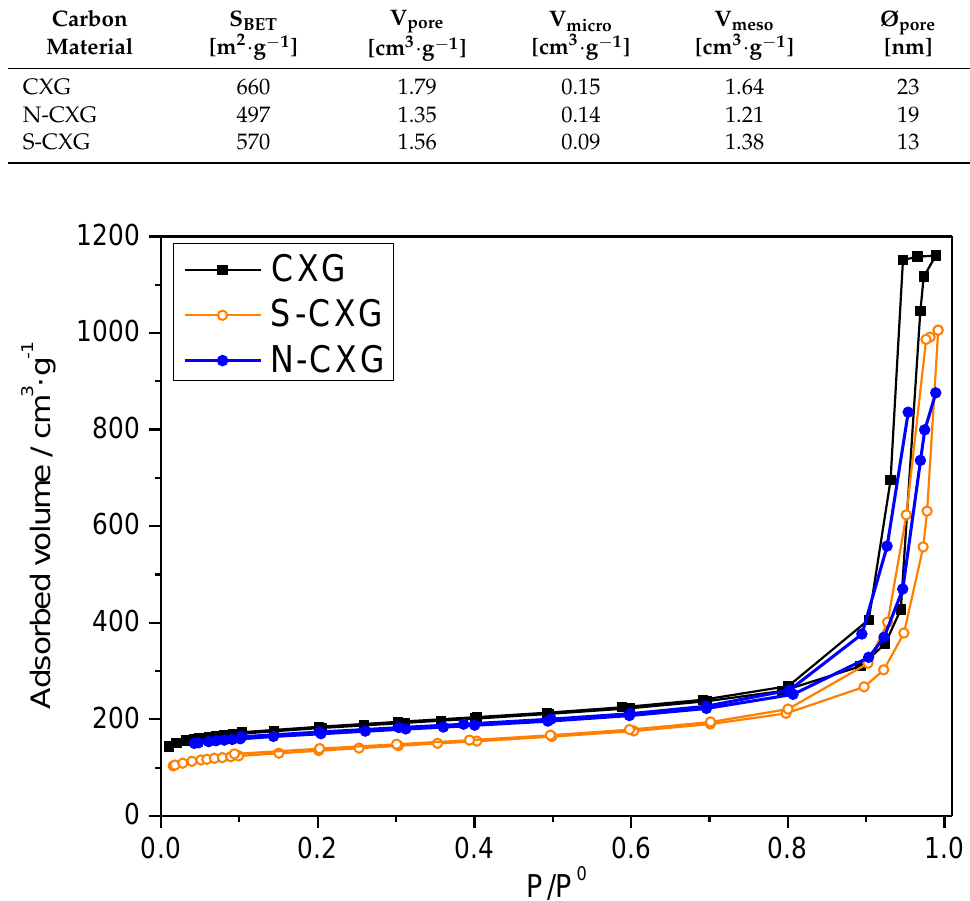
Figure 1. Adsorption–desorption isotherms obtained from N 2 physisorption performed at 77K for the carbon materials under study: CXG (black), N-CXG (blue) and S-CXG (orange).